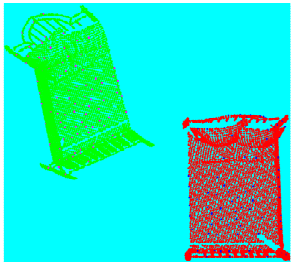
Figure 5. ISS feature points.